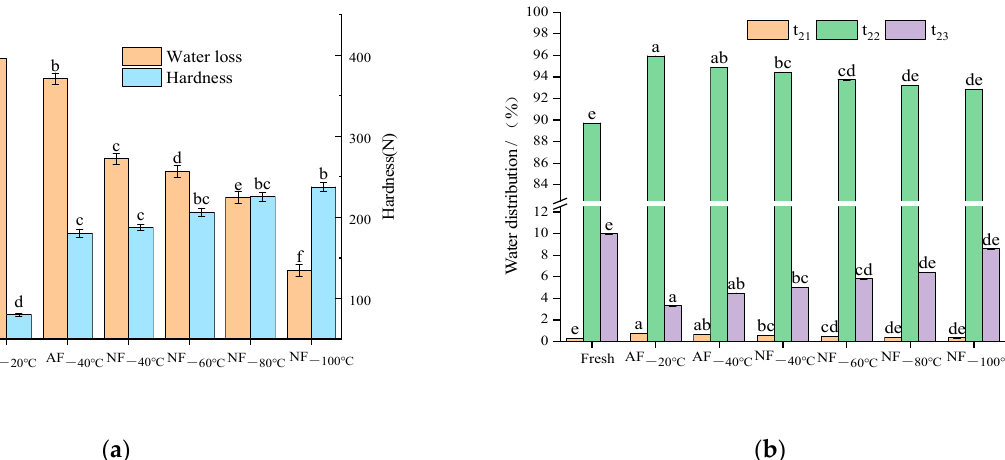
Figure 3. E ff ects of di ff erent freezing treatments on the ( a ) water loss and hardness; ( b ) water distri- Figure 3. Effects of different freezing treatments on the ( a ) water loss and hardness; ( b ) water bution of chestnut kernels. distribution of chestnut kernels. Note: In each figure, different letters mean significant differences ( p <